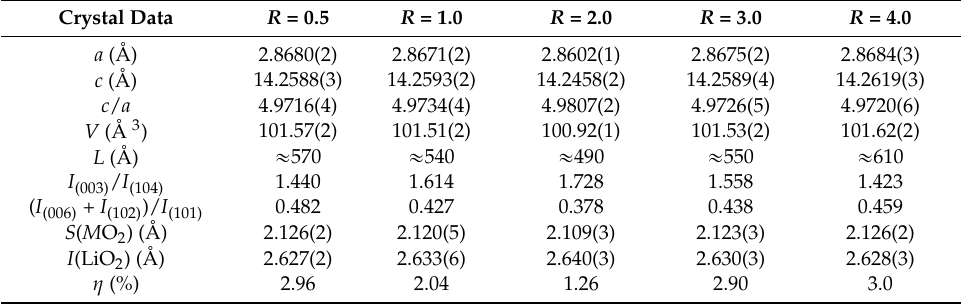
Table 4. Structural data of the LiNi 1/3 Mn 1/3 Co 1/3 O 2 samples synthesized at different values of R . a , c are the lattice parameters, V is the volume of the unit cell, and L the coherence length (crystallite size). The coherence length is the arithmetic average of the length given by the Scherrer law applied to three main XRD lines. The two next lines are relative intensities of the XRD lines that provide insight on the concentration of Ni 2+ (3 b ) defects. The other X-ray Rietveld refinement parameters are reported in the last lines. S ( M O 2 ) = 2( 1 { 3 - z oxy ) c is the thickness of the metal–O 2 planes, I (LiO 2 ) = c /3- S ( M O 2 ) is the thickness of the interslab space; other notations are